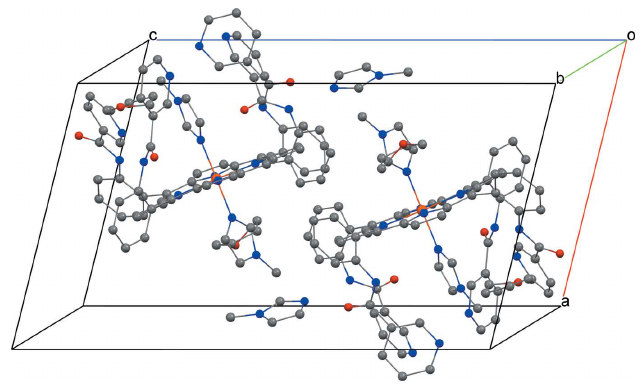
Figure 4 A view of the molecular packing of the title compound. Hydrogen atoms are omitted for